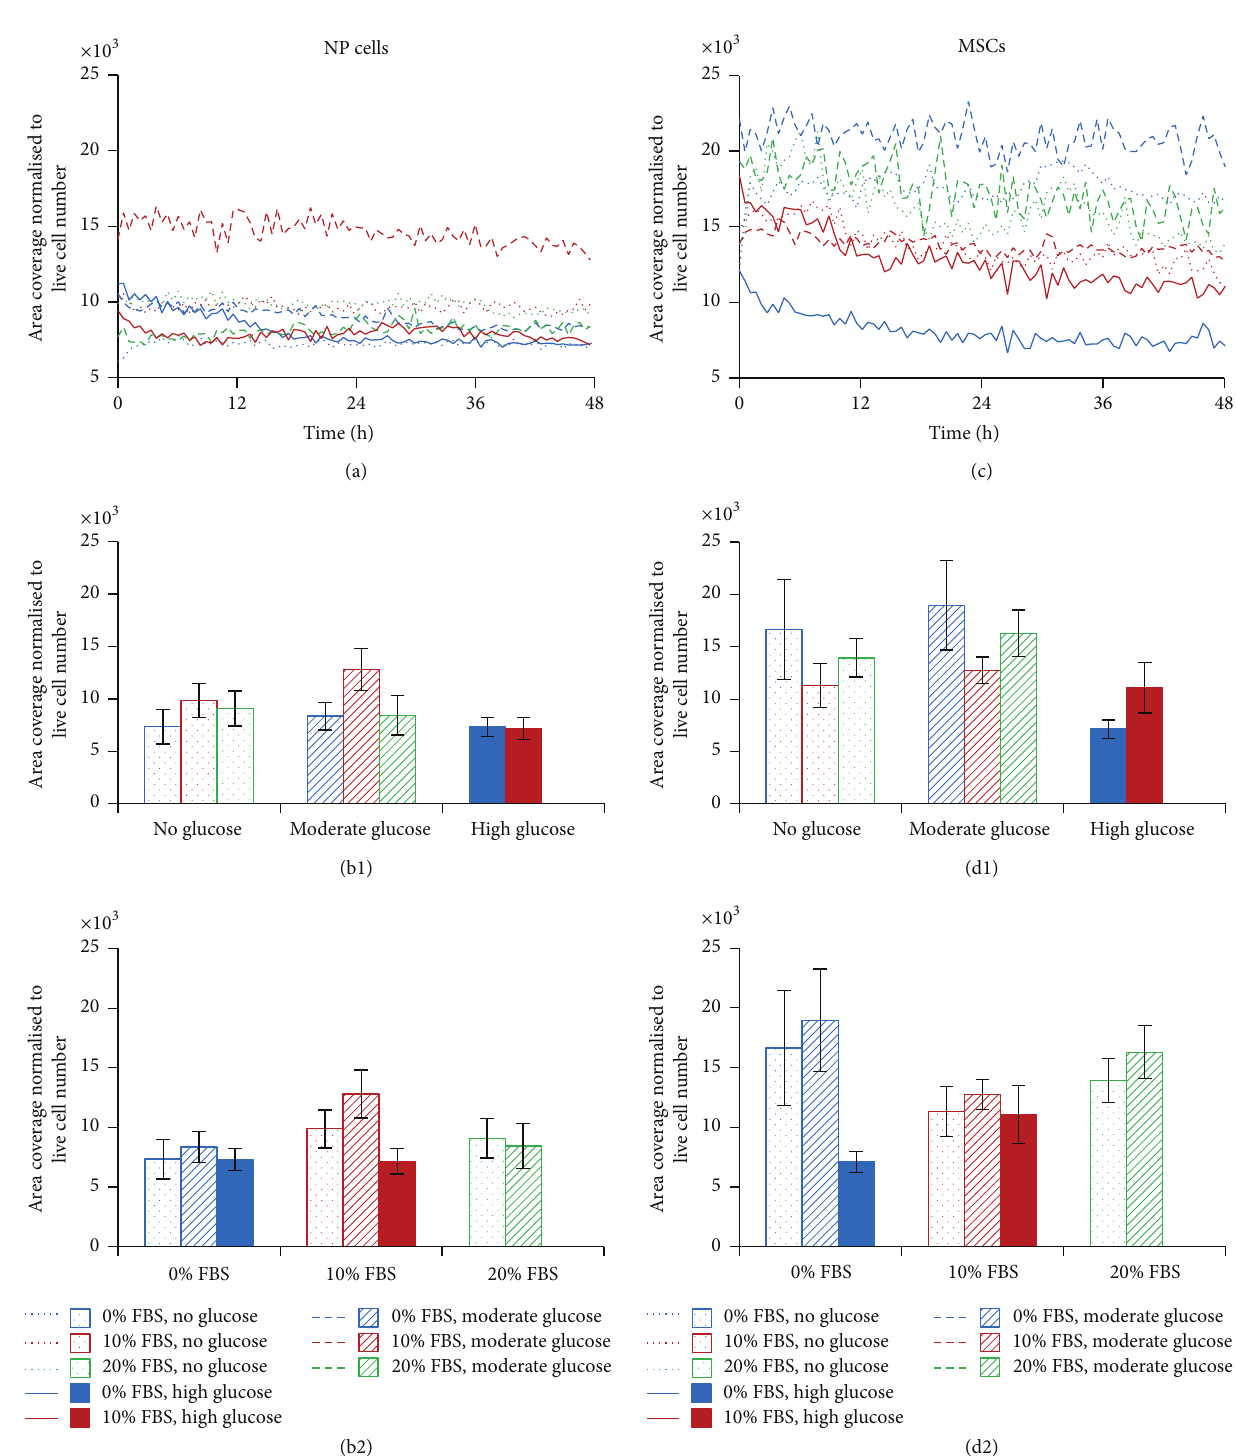
Figure 5: Temporal analysis of human NP cell and MSC area coverage in response to FBS and glucose concentration over 48 hours. Trends over 48 hours for human NP cells (a) and human MSCs (c). Mean area coverage, normalised to live cell number at the final time point ( ± SEM) for (b) human NP cells and (d) human MSCs, comparing FBS levels within glucose subgroups ((b1) and (d1)) and comparing glucose levels within FBS subgroups ((b2) and